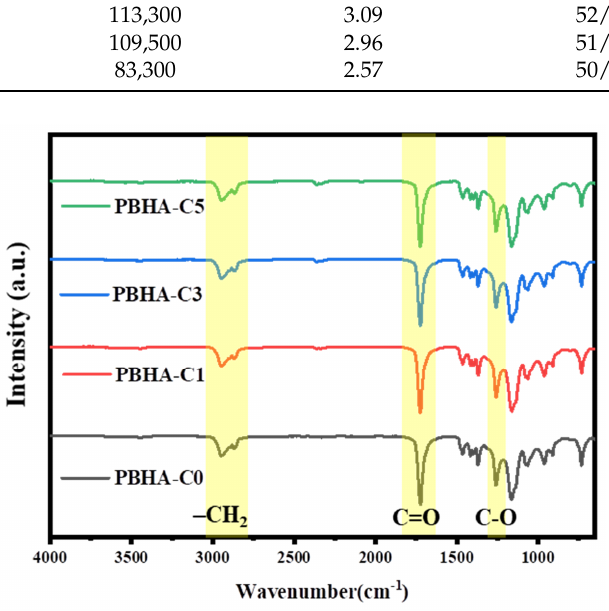
Figure 2. FT-IR spectra of PBHA-Cn copolymers.